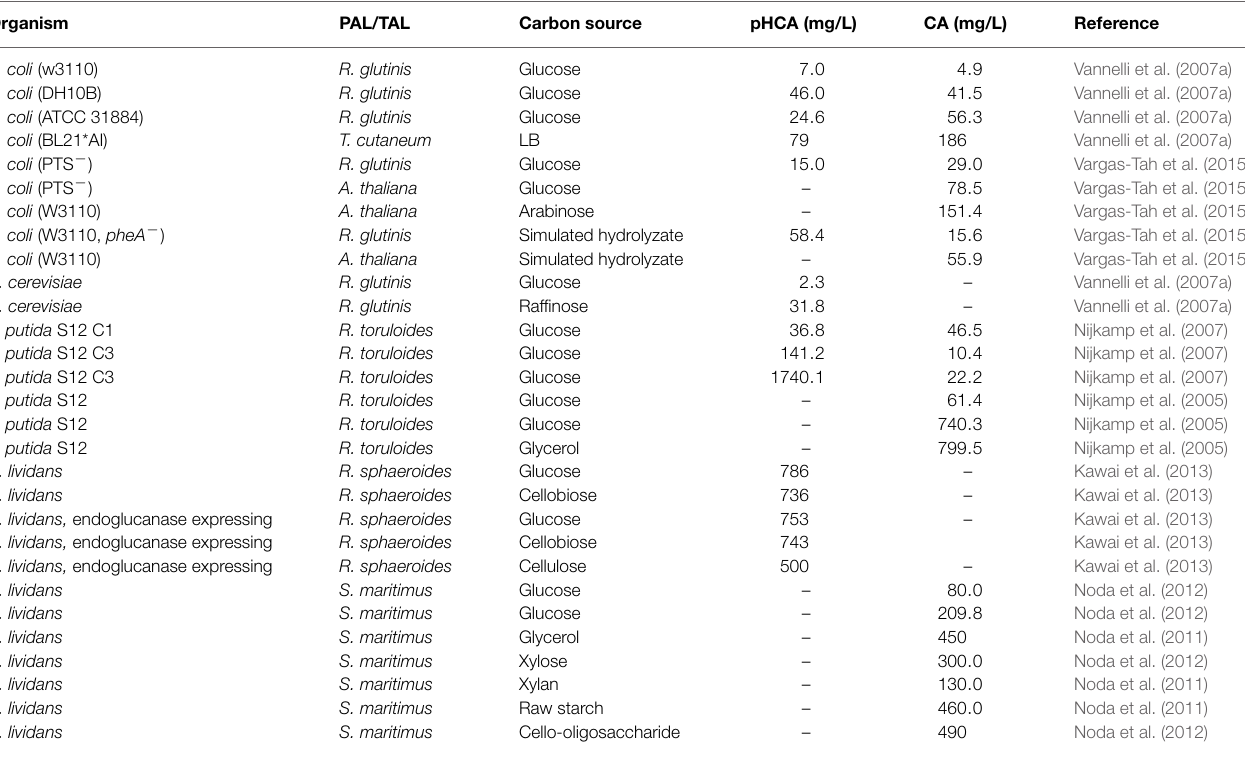
TABLE 2 | Comparison of production parameters for aromatic acids synthesized by engineered microbial strains .